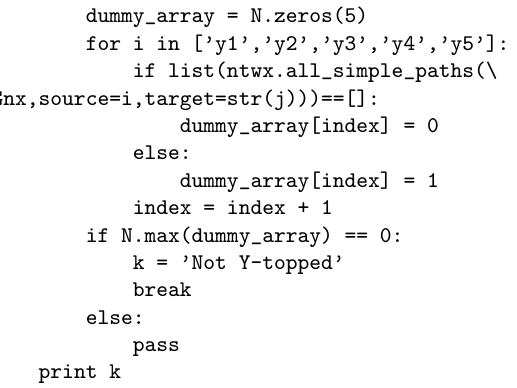
Consider figure 9. The two elementary paths y 1 → V ed → ˙ V ed 2 w and y 2 → V em → ˙ V ew 2 m are two